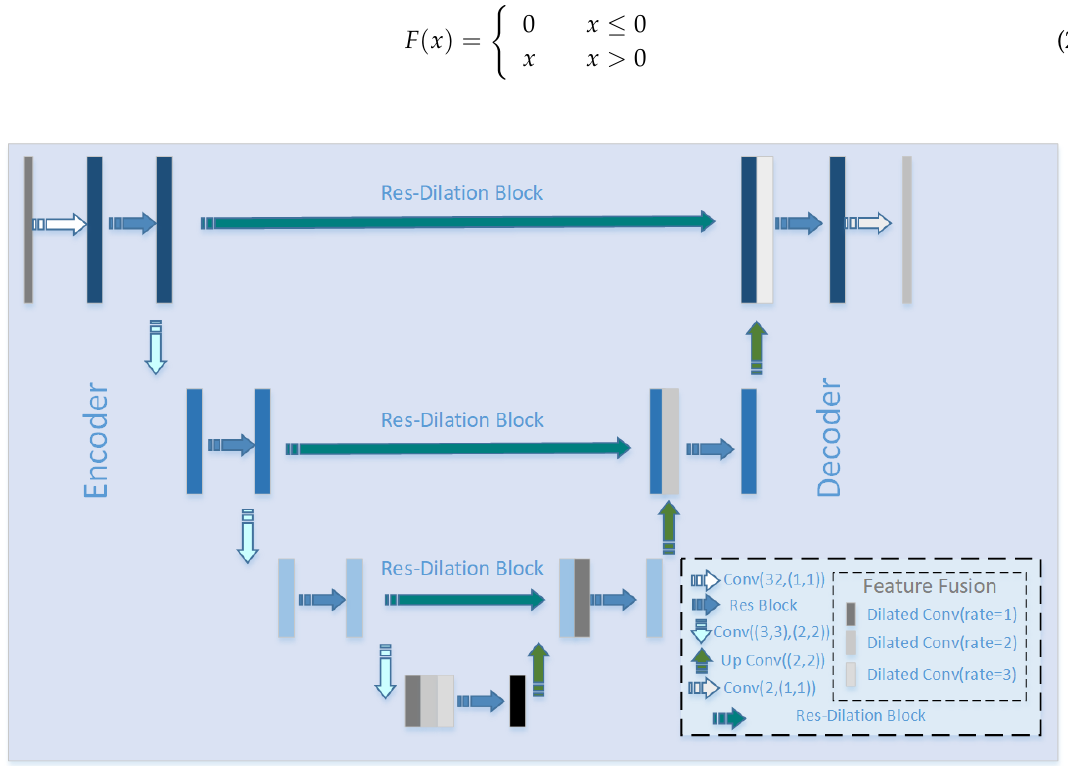
Figure 5. Improved U-shaped neural network (MRU-Net) structure: the structure of the MRU-Net model is described in the lower right corner of the figure, including the methods used for encoder–decoder, feature fusion, and skip connection.